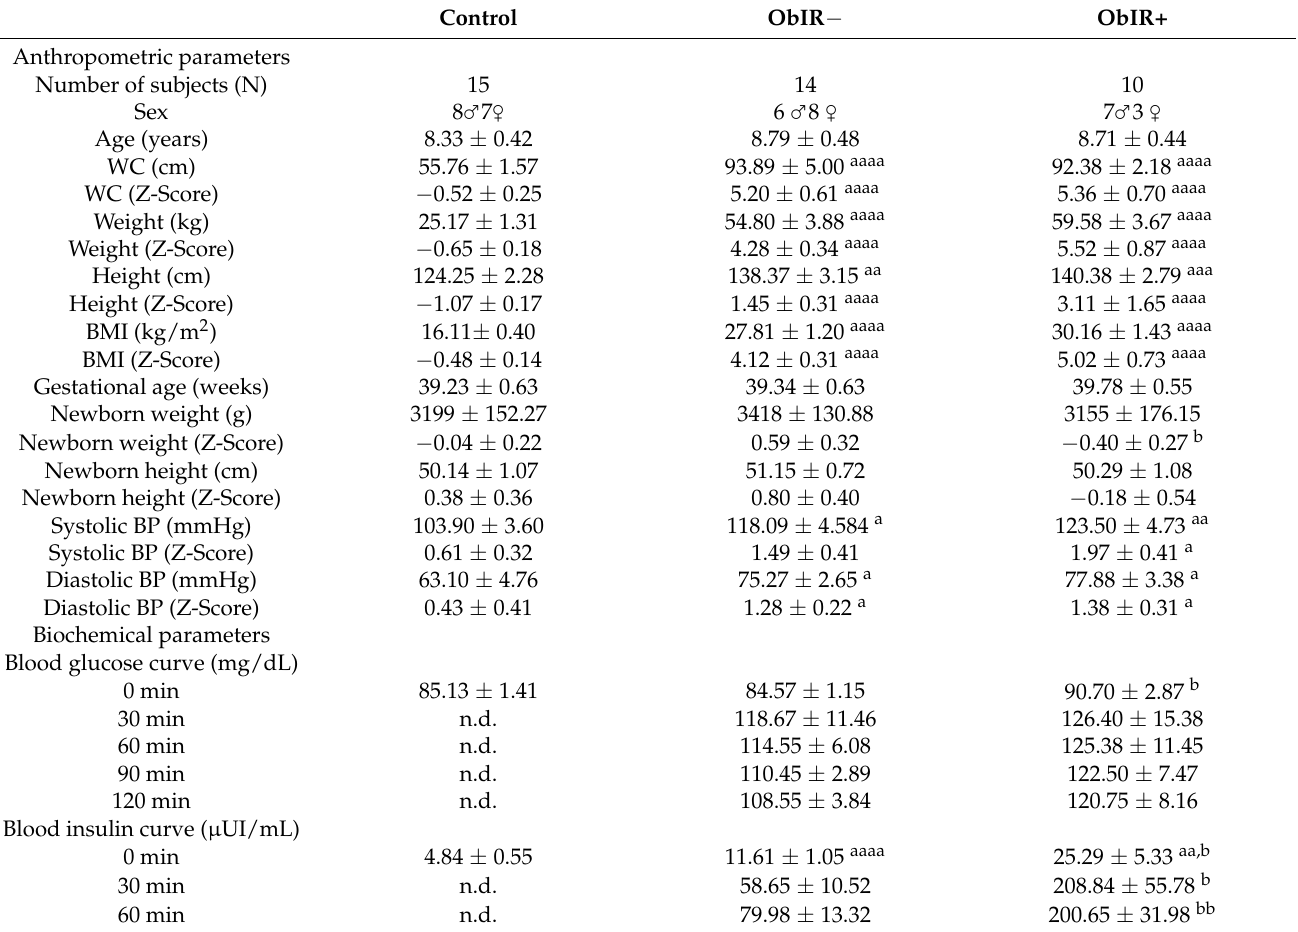
Table 1. Anthropometric and biochemical characteristics of the study population. Control ObIR −